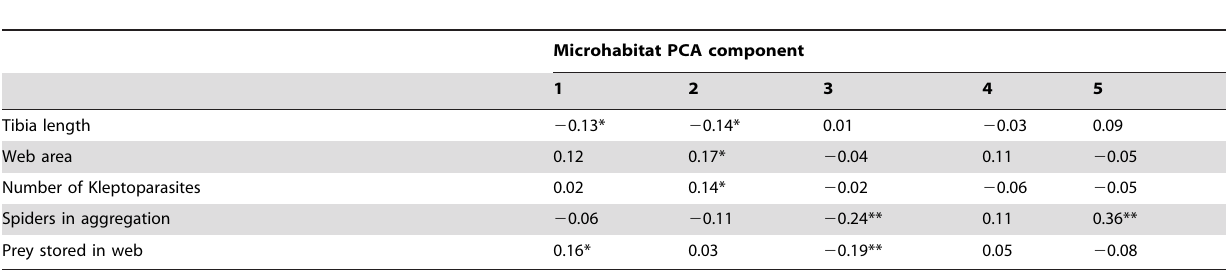
Table 2. Pearson’s R correlations between the components of the microhabitat PCA, size and microhabitat variables (*P , 0.05, **P ,